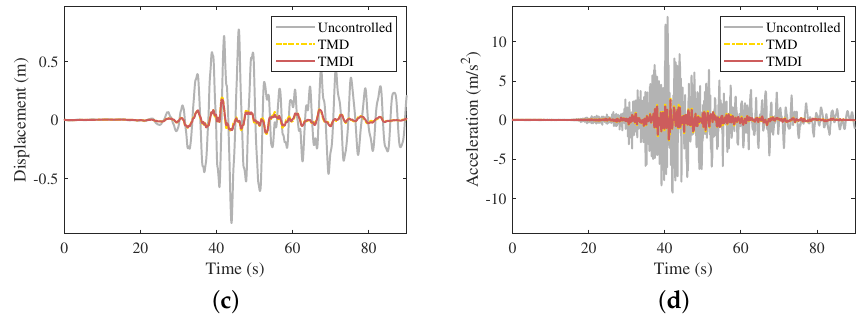
Figure 17. The top response of the main structure under ground motion of R2: ( a ) Displacement under passive control; ( b ) Acceleration under passive control; ( c ) Displacement under active control; ( d ) Acceleration under active control.